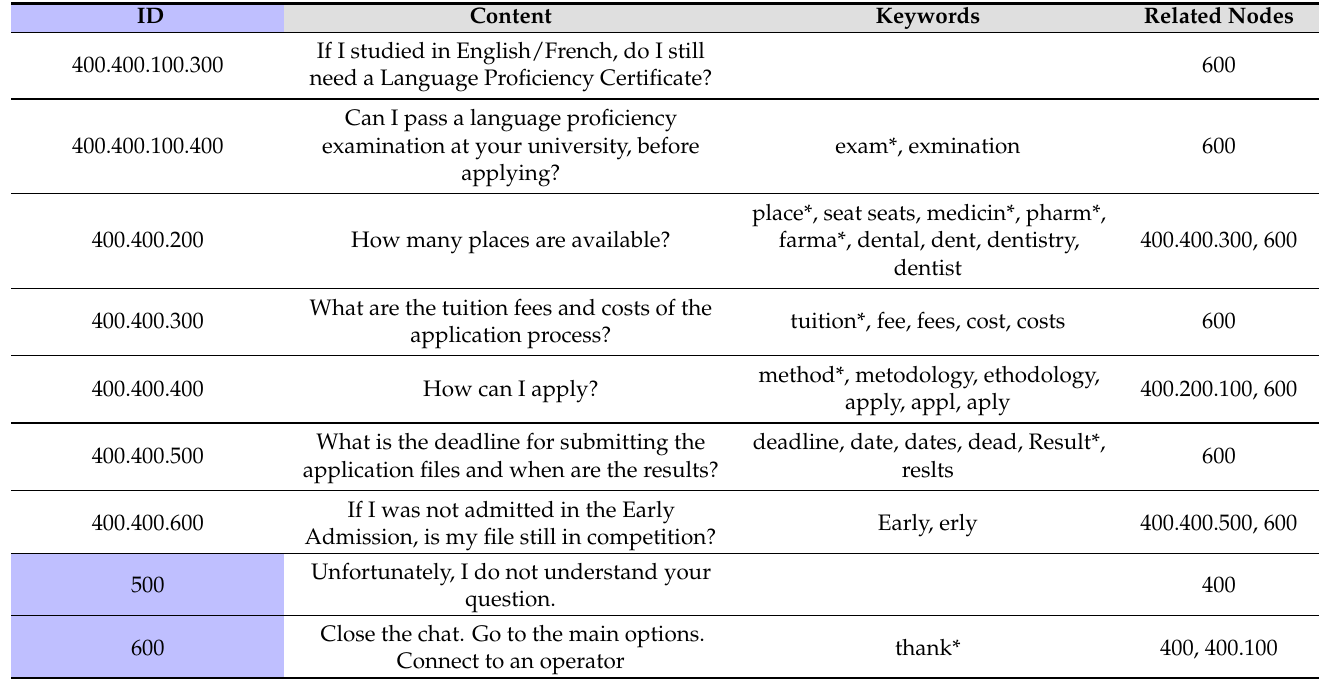
Table 2. The questions known by the chatbot